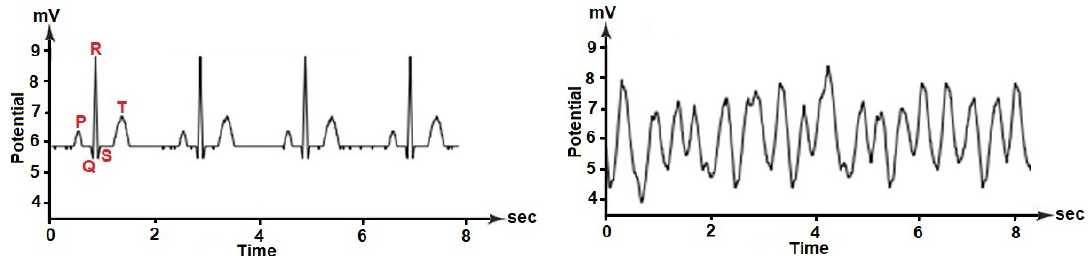
Figure 1. Example of ECG signals during normal heart rhythm ( left ) and during VF ( right